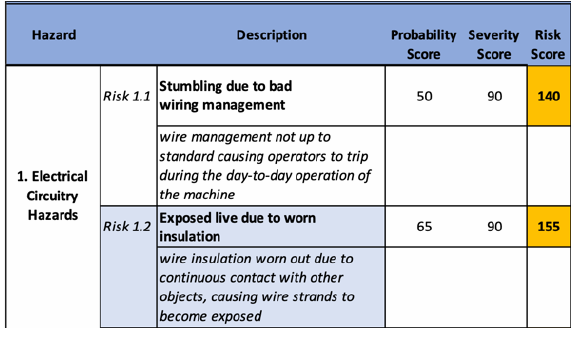
Figure 6. Risk Scoring Step 3: Generate Module